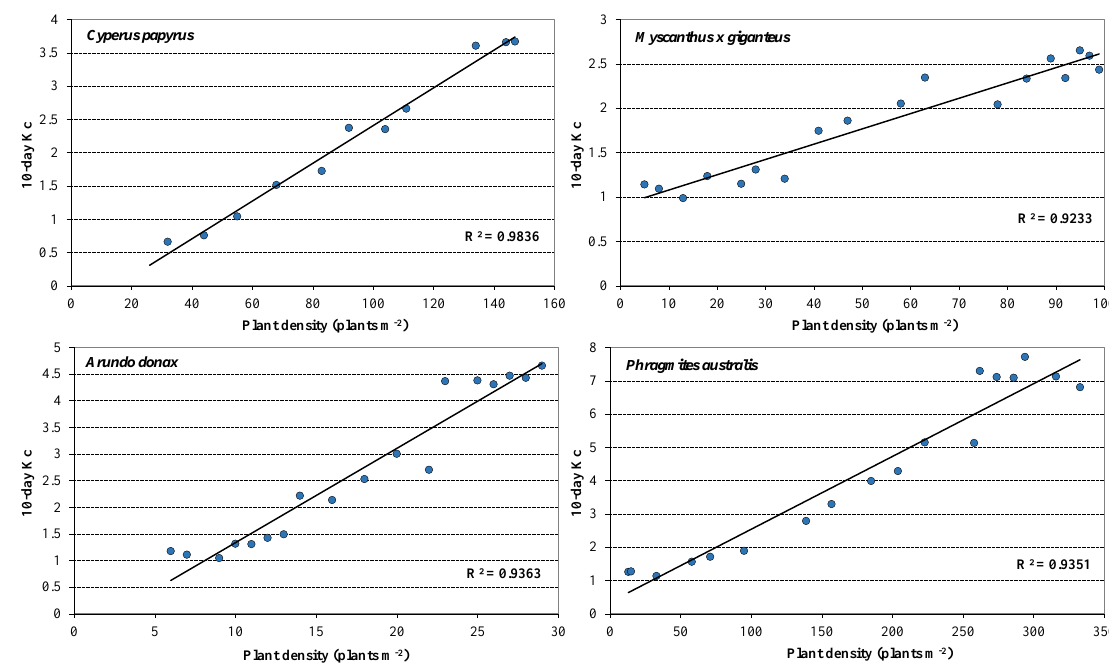
Figure 11. Relationship between 10-day K c and plant density for C. papyrus , M. giganteus , A. donax, and P. australis from April to September 2012.